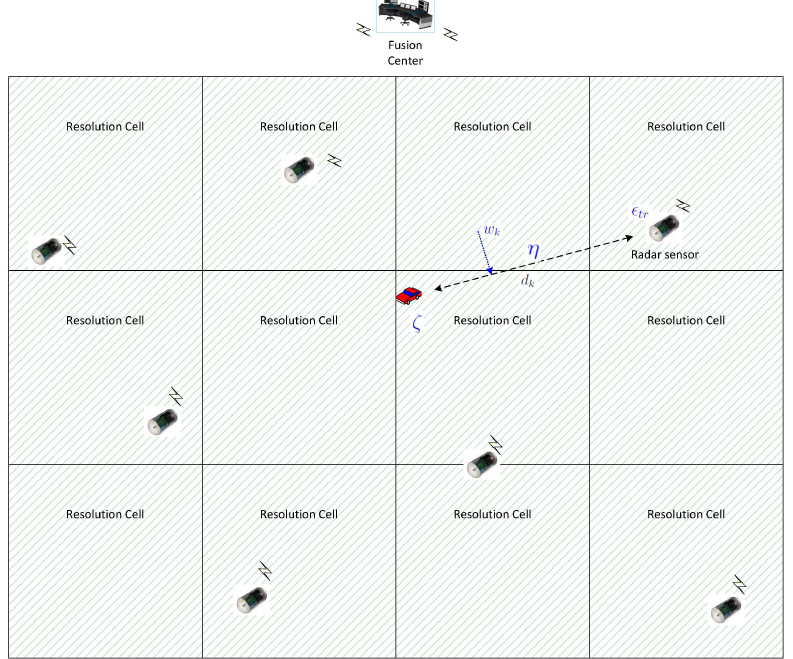
Figure 1. Decentralized detection for a surveillance area with randomly-placed radar-like